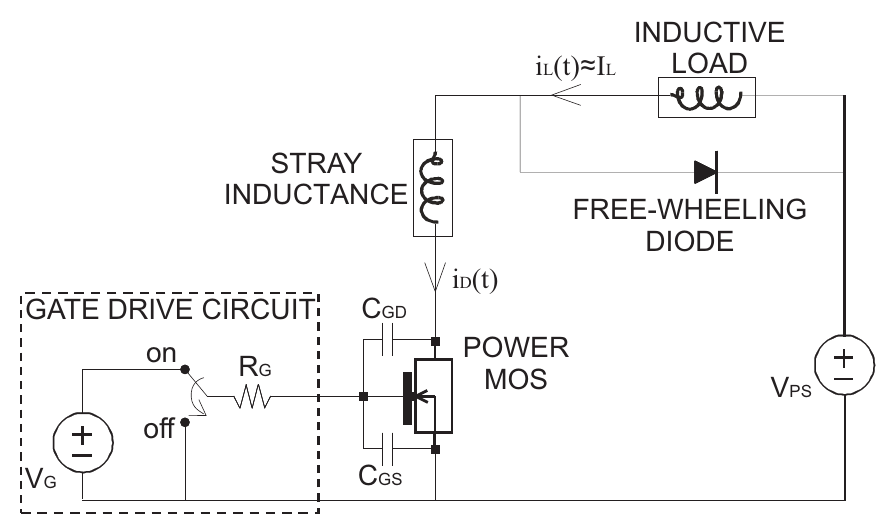
Figure 2. Power MOSFET device operating in an inductive load